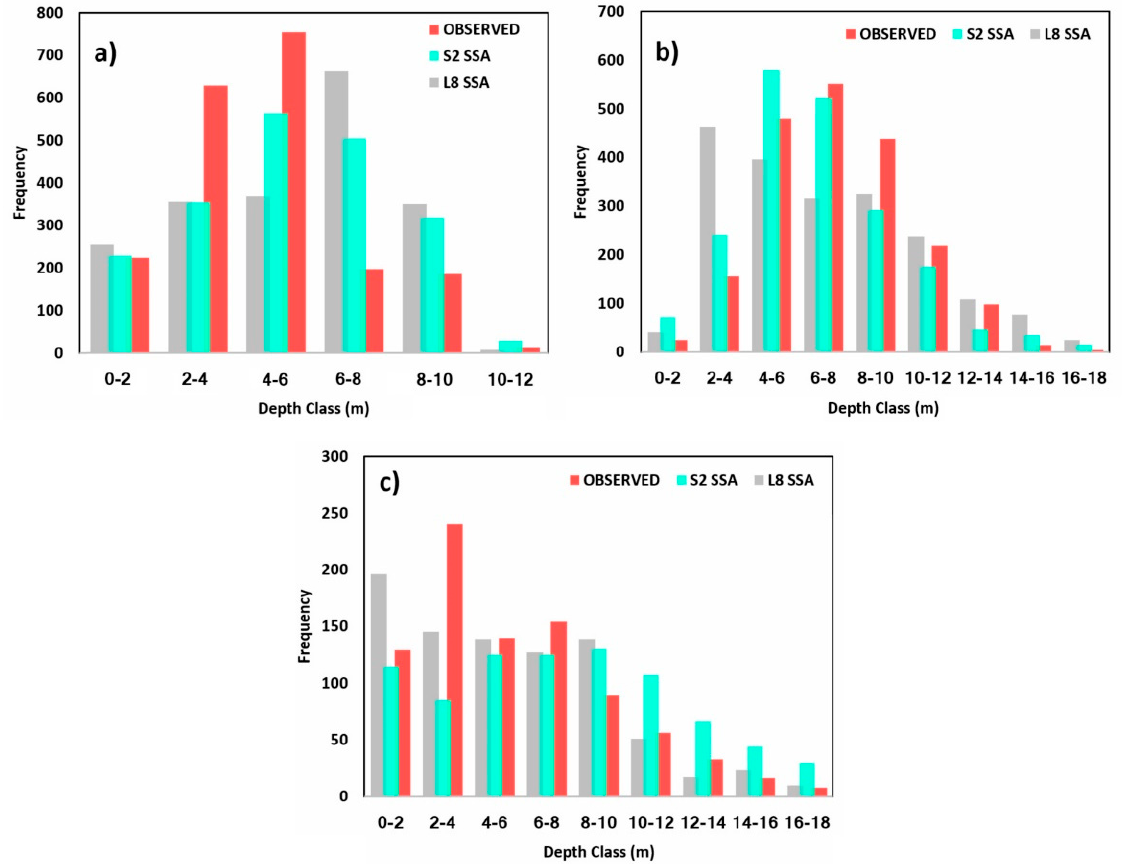
Figure 10. Histogram of depth classes for comparison between different bathymetric maps: ( a ) Mobile Bay; ( b ) Tampa Bay; ( c ) Lake Huron.